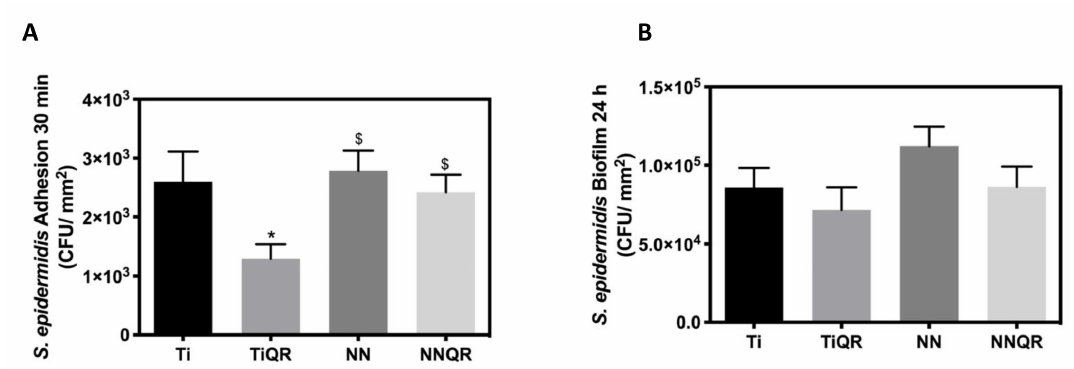
Figure 6. Staphylococcus epidermidis adhesion and biofilm formation. ( A ) S. epidermidis adhesion after 30 min of incubation. ( B ) S. epidermidis biofilm formation after 24 h of incubation on the surfaces. Values represent the mean ± S.E.M., ( n = 6). Three di ff erent experiments were performed in duplicate. Results were statistically compared by Kruskal–Wallis for bacterial adhesion and an ANOVA and Bonferroni as a post hoc for biofilm formation. * p < 0.05 versus Ti; $ p < 0.05 versus